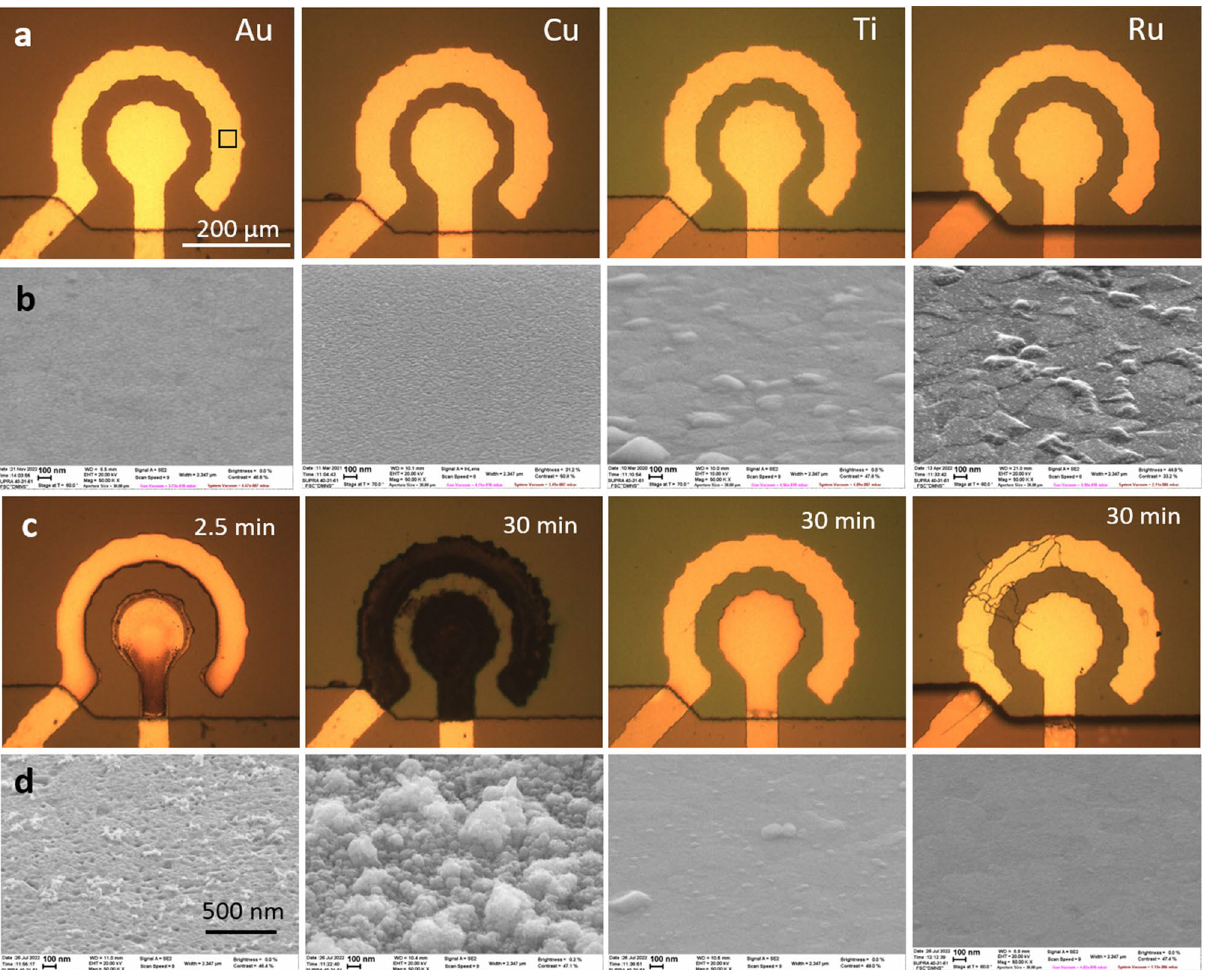
Figure 3. Degradation of electrodes from different materials. ( a ) (row) Optical images of the electrodes from different materials before the test. ( b ) (row) SEM images of electrodes before the test. Specific roughness of Au, Ti, and Ru because of the underlying Al. ( c ) (row) Optical images of the electrodes after application of the AP pulses with f = 500 kHz and U = 7 V during 2.5 min for Au and 30 min for other materials. ( d ) (row) SEM images after the test of the rim electrode in the place marked by the black rectangular for Au. All SEM images ◦ are made at a stage angle of 60